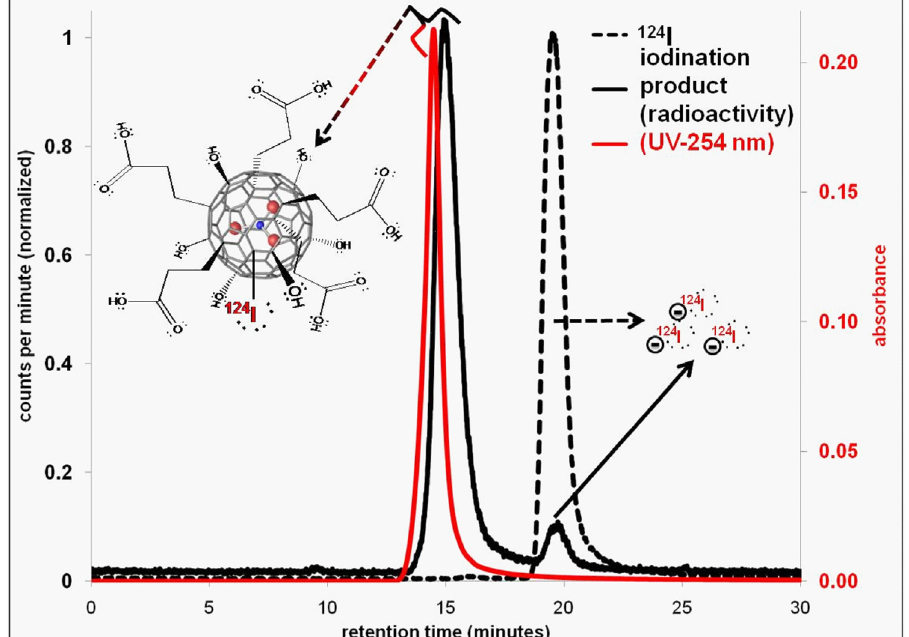
Figure 5. Analysis by HPLC of the iodinated product 124 I-f-Gd showing detection by UV absorption (red trace—right axis) and radioactivity (black trace—left axis). The slight offset in the two traces is due to the detectors being connected in series. The trailing peak in the radioactive trace for the 124 I-f-Gd confirmed to be free 124 I as evidenced in the matching retention time for 124 I alone injection (dashed line—black